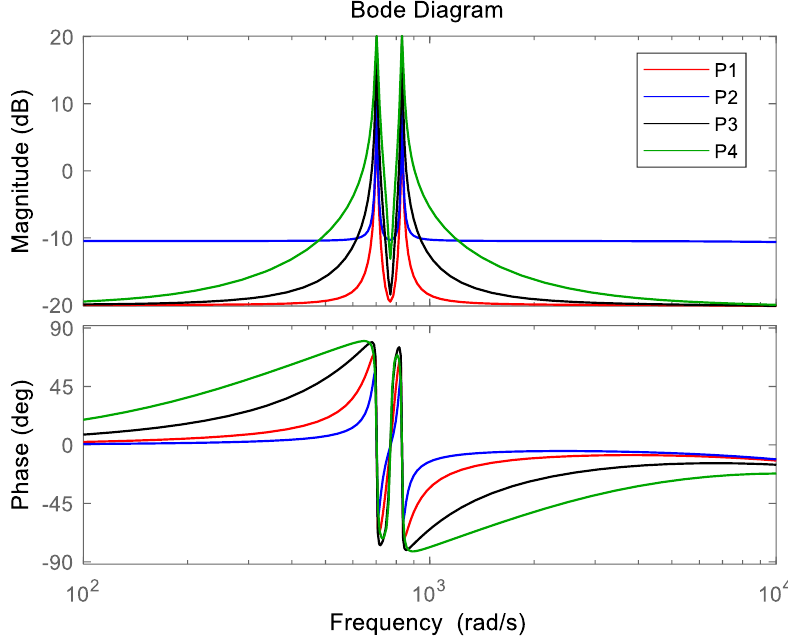
Figure 6. System bode diagram under different parameters. Figure 7 is the pole-zero diagram and the Nyquist diagram, respectively.